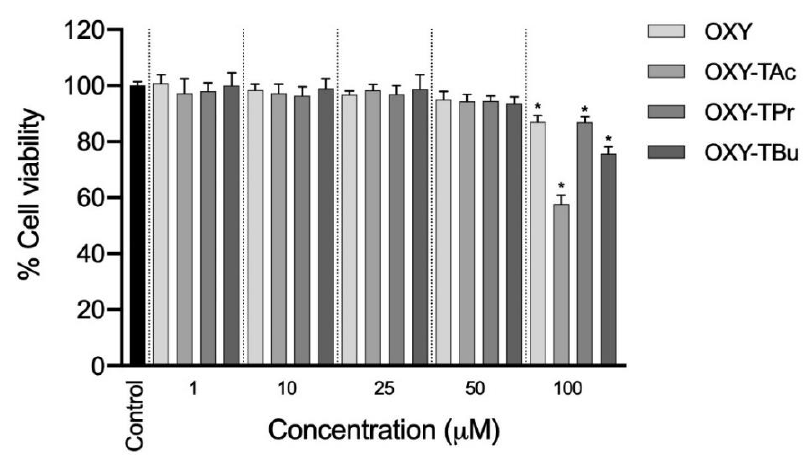
Figure 2. The viability of Caco-2 cells after 24 h exposure in OXY and four OXY ester prodrugs (1 – 100 µM). The data are expressed as the mean of four replicates ± SD. * p < 0.05 vs. control